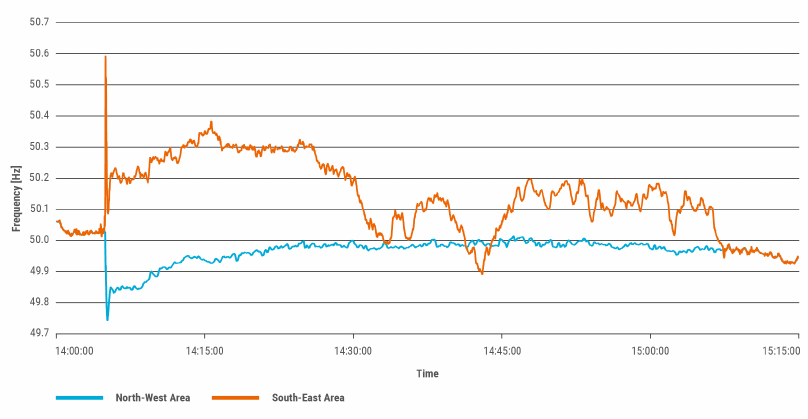
Figure 8. Frequency of the two separated areas of the CE system during the system split